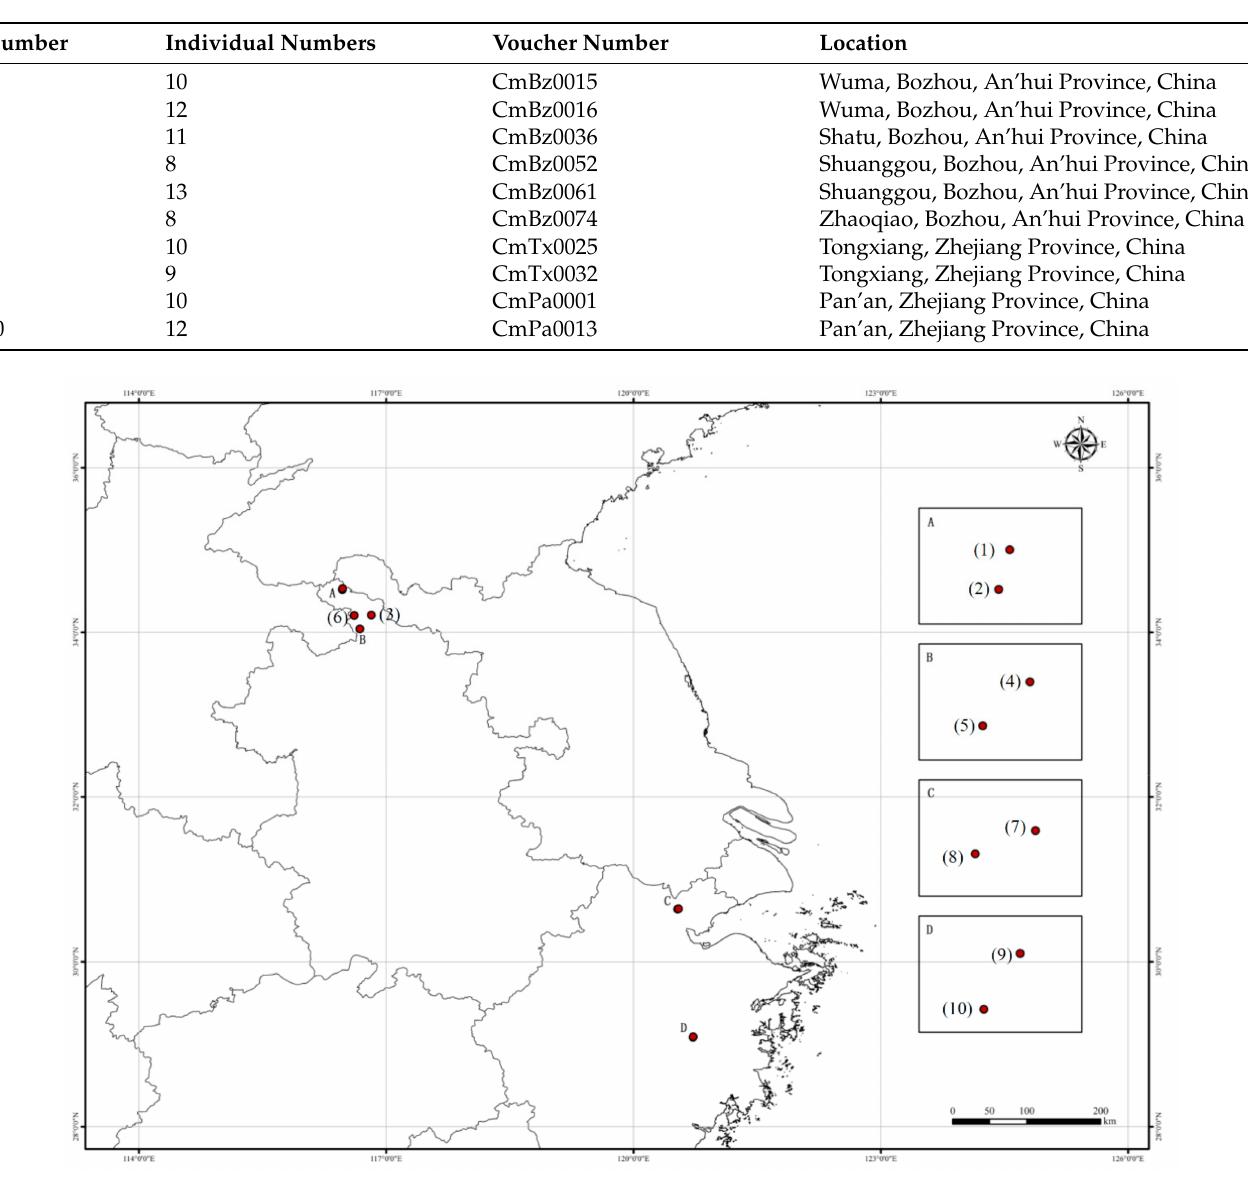
Table 5. List of C. morifolium ‘Daboju’ populations used for SCAR marker validation.